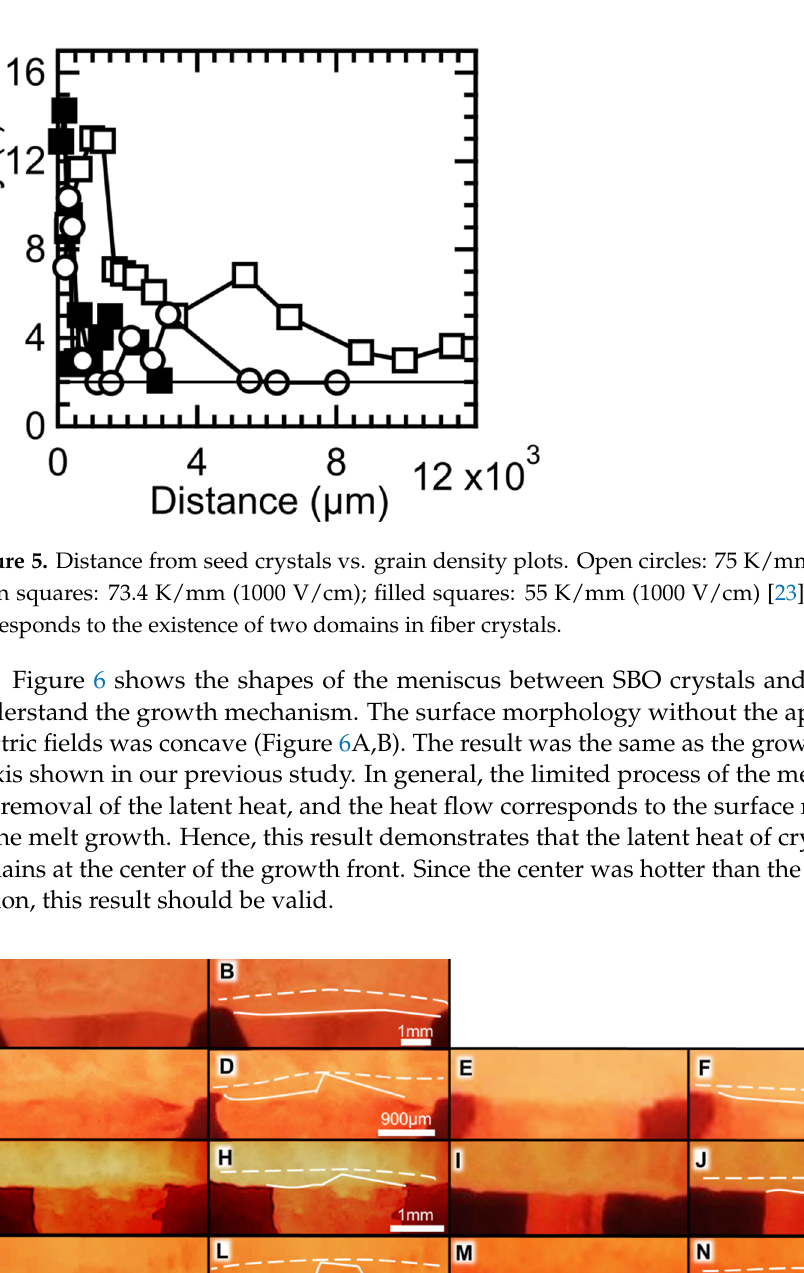
Figure 7. Crystal structure of SBO [6]. ( A ): (100) face perpendicular to the paper; ( B ): (010) face perpendicular to the paper; ( C ): (001) face perpendicular to the paper. Green, red, blue balls cor- respond to strontium, oxygen, and boron atoms, respectively. Symbols in the individual drawings show the crystallographic orientation. Dashed lines depict the position of mirror planes. Now we focus on the frequency of the geometrical selection to understand the rea- son. During the geometrical selection, the growth faces, which show fast crystal growth, preferentially survive. We expect that some domains in Figures 3F, 4F, A1F, and A2F